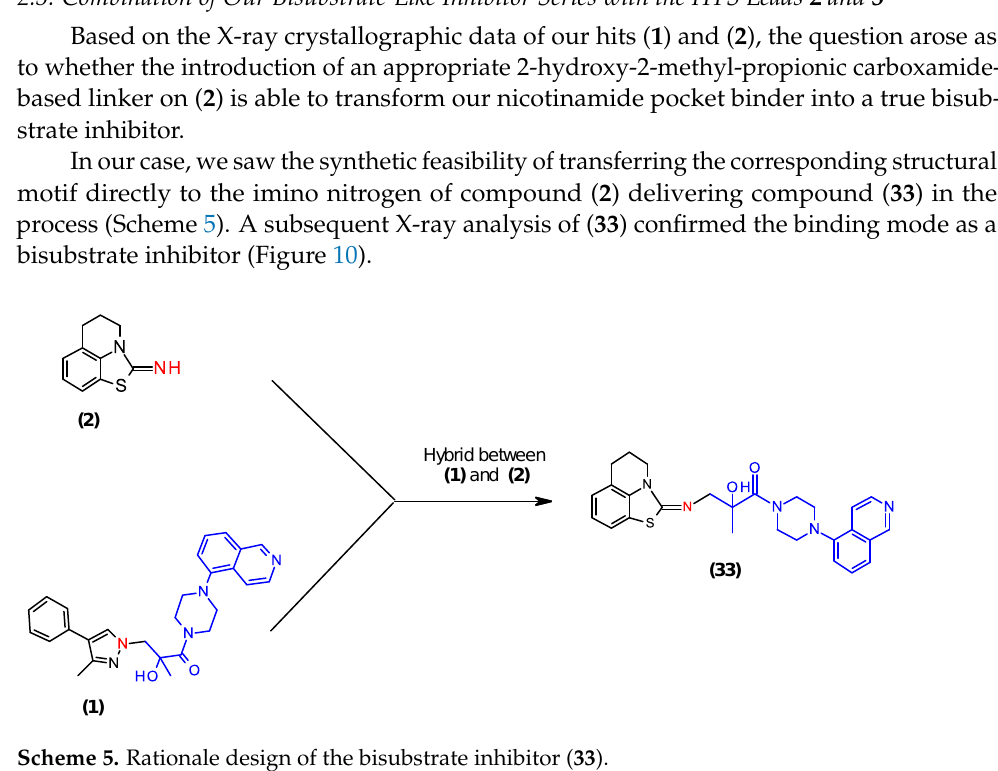
Figure 10. Crystal structure showing the binding mode of ( 33 ) (cyan) to hNNMT. ( a ) Comparison with the crystal structure of inhibitor ( 1 ) (blue). ( b ) Comparison with the crystal structure of the SAH and compound ( 2 ) complex (yellow). Further profiling on human and mouse NNMT enzyme revealed that a bisubstrate binding motif does not necessarily translate into an improved inhibitory activity (Table 4). This may be related to the fact that a bisubstrate inhibitor has to compete with two substrates, SAM and Nam, which may be more difficult to achieve than when competing with a single substrate, especially when the second substrate, SAM, has a high affinity to